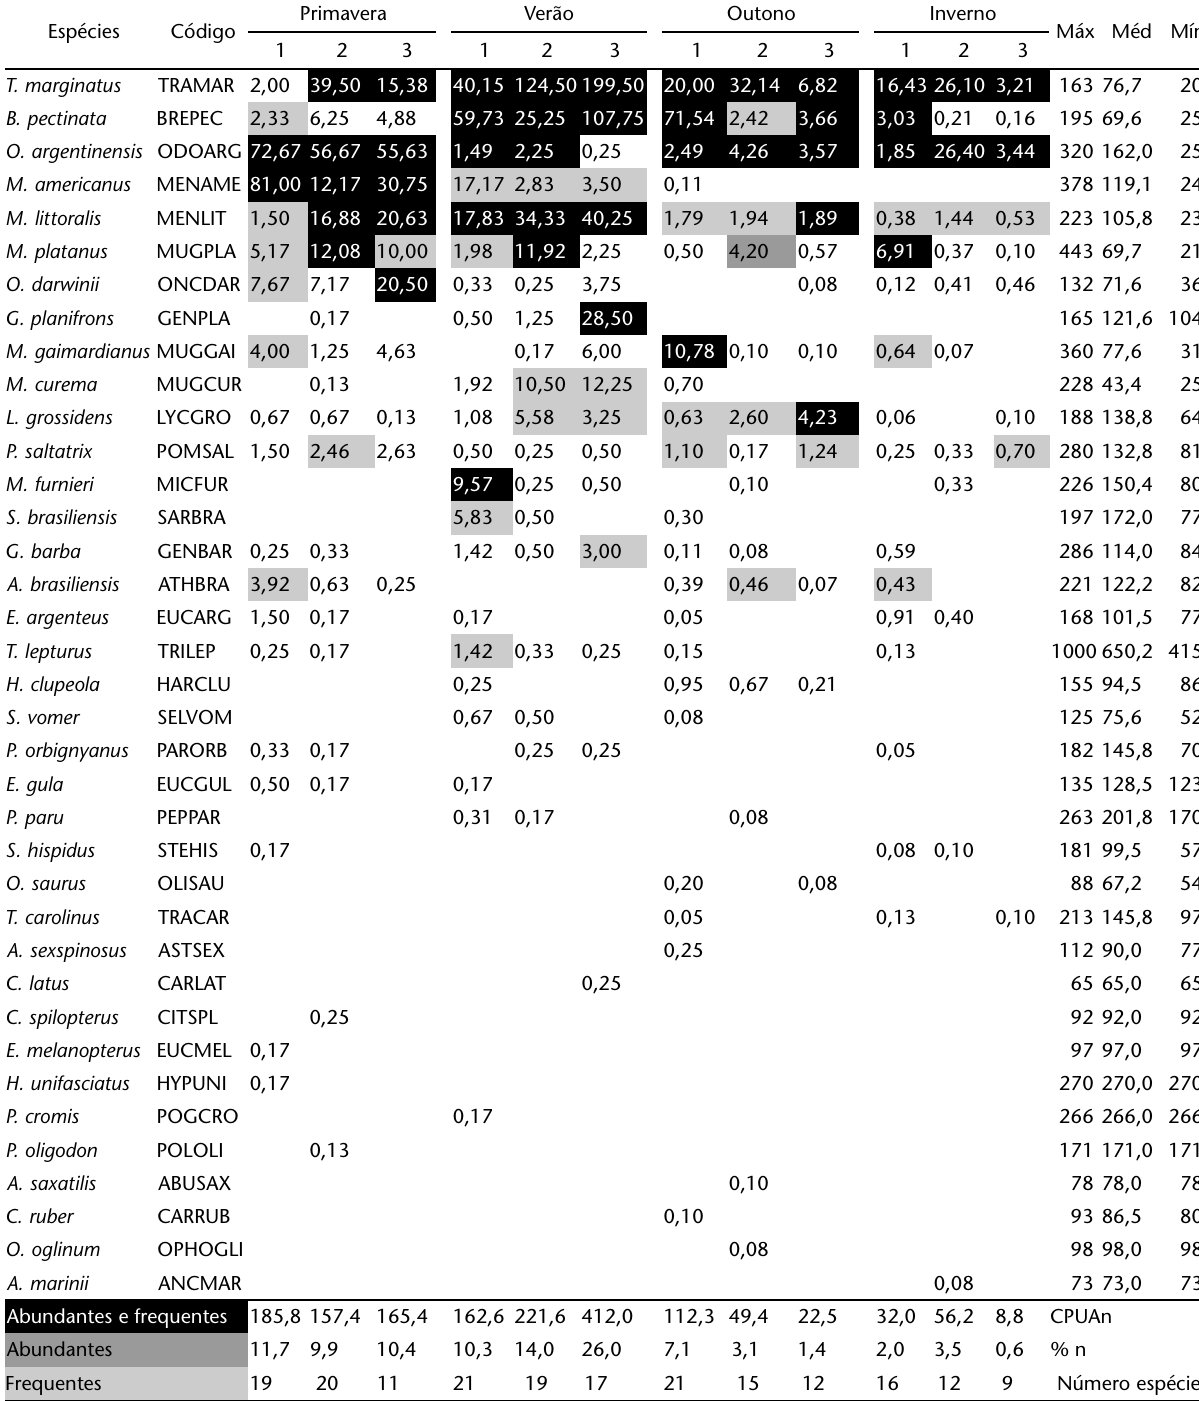
Tabela II. Lista das espécies por estações do ano e locais de coleta (1, 2 e 3) em ordem decrescente de abundancia relativa e freqüência de ocorrência, com comprimentos (CT) máximo, médio e mínimo. As espécies mais representativas estão representadas em escala